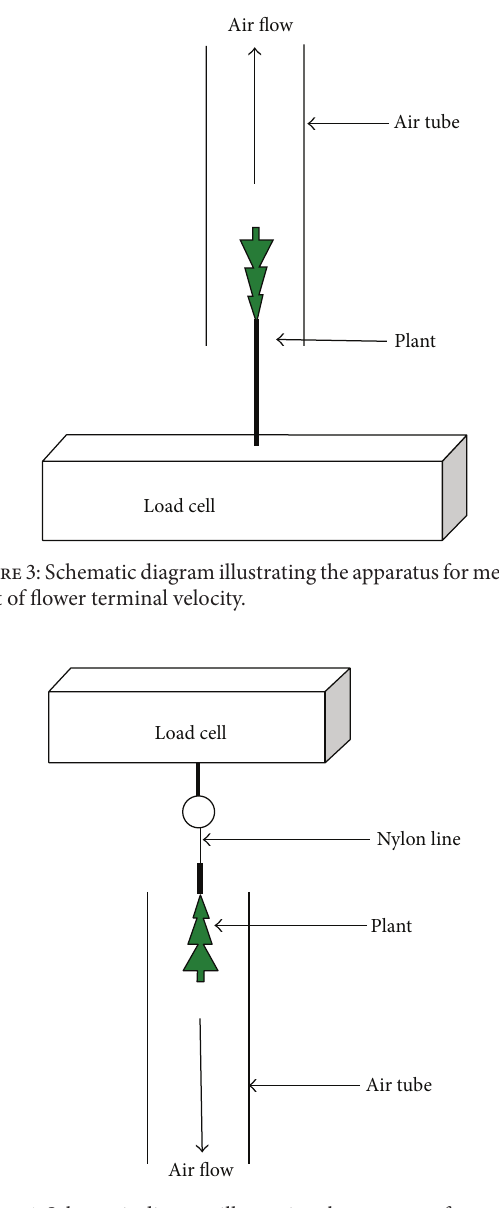
Figure4:Schematicdiagramillustratingtheapparatusformeasure- ment of flower aerodynamic drag